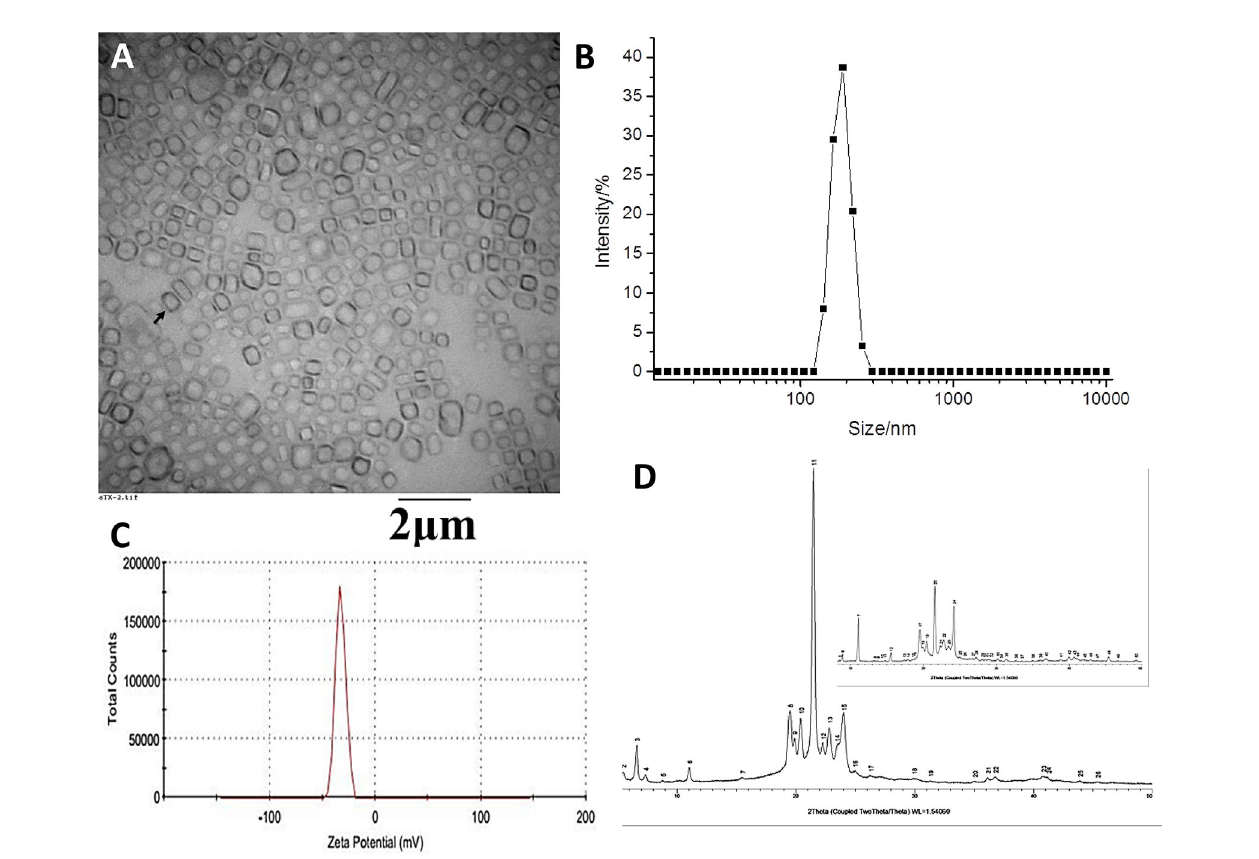
FIGURE 2 | Physical characterization of the anlotinib nanocrystal. (A) Transmission Electron Microscope (TEM) images of anlotinib nanocrystal; (B) distribution of the anlotinib nanocrystals ’ particle sizes; (C) zeta potential of the anlotinib nanocrystals; and, (D) X-ray diffraction images displaying the anlotinib crystal shape. The black arrow (A) indicates the anlotinib nanocrystal